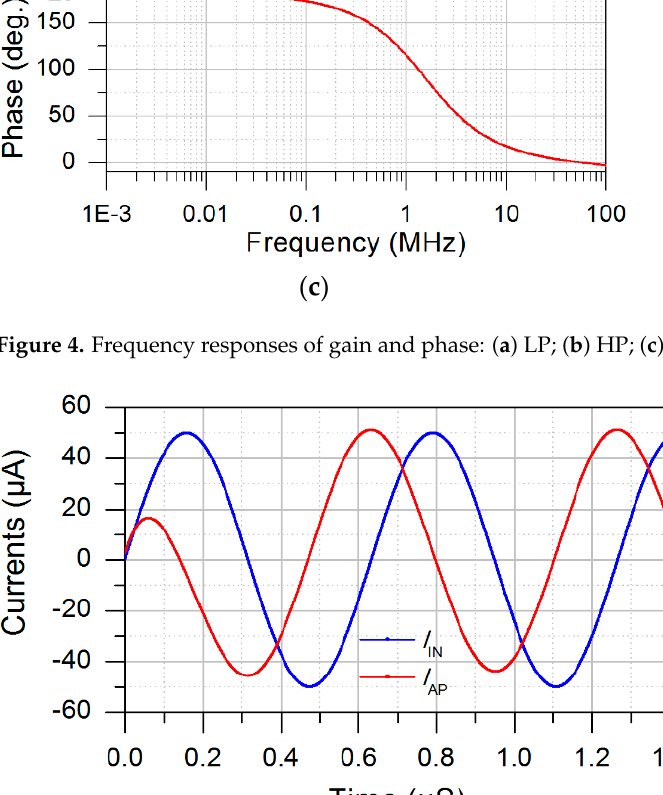
( b ) Figure 6. Frequency responses of AP filter at different bias current for ( a ) gain and ( b ) phase. Figure 7. Differential input current and differential AP output current at 73 MHz. Figure 8. Transient responses of differential AP output currents at 0, 25, 50 and 75 °C.